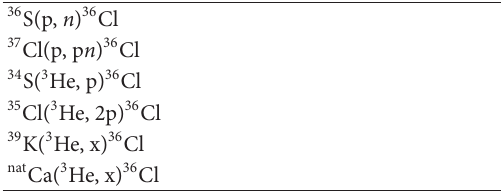
Table 2: Nuclear reactions considered in this paper.